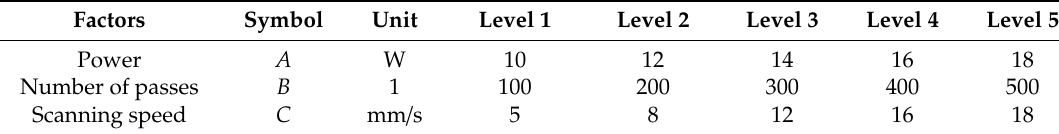
Table 1. Values of factors in di ff erent levels.